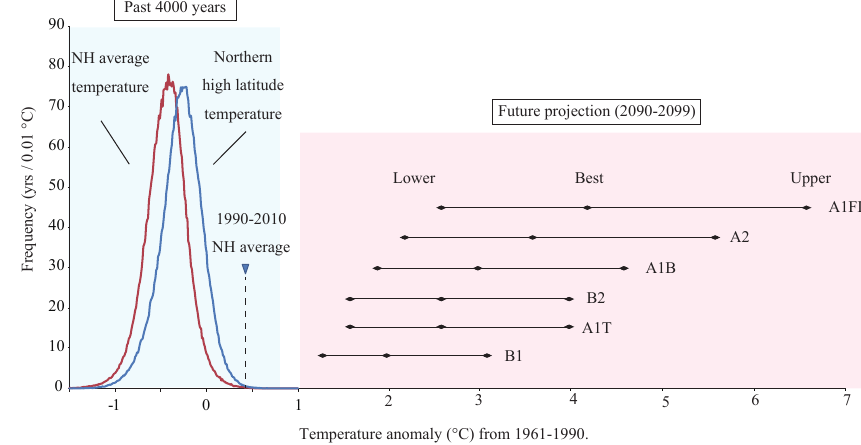
Fig. 9. Histogram of estimated NH and NHL temperature anomalies over the past 4000yr. Distribution of temperature anomalies was estimated by a Monte Carlo simulation. Normally distributed random numbers (mean zero and unit standard deviation) were generated, and multiplied with 1 σ uncertainties of the time series. Then, it was added to the original time series to generate 100 synthetic time series of each NH and NHL temperature anomaly for the period 2000BCE to 1850CE. Then, histograms were created with all the synthetic data plus the original data, and then the values for each bin were divided by 101. Future projections from IPCC AR4 (Meehl et al., 2007) were originally referenced to 1980–1999, but they were adjusted to the reference to 1961–1990 by adding 0.19 ◦ C, i.e. the difference of the NH average temperature anomaly between 1980–1999 and 1961–1990 (HadCRUT3) (Brohan et al.,